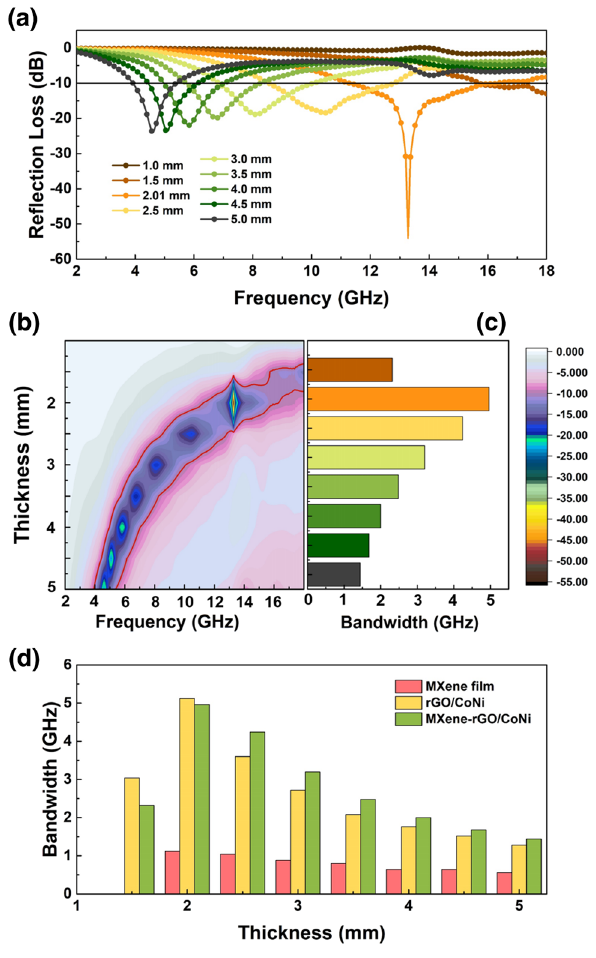
Fig. 7 a RL curves vs frequency, b 2D representation of RL values and c bandwidth values of MXene-rGO/CoNi films, d compared bandwidth of MXene, rGO/CoNi and MXene-rGO/CoNi